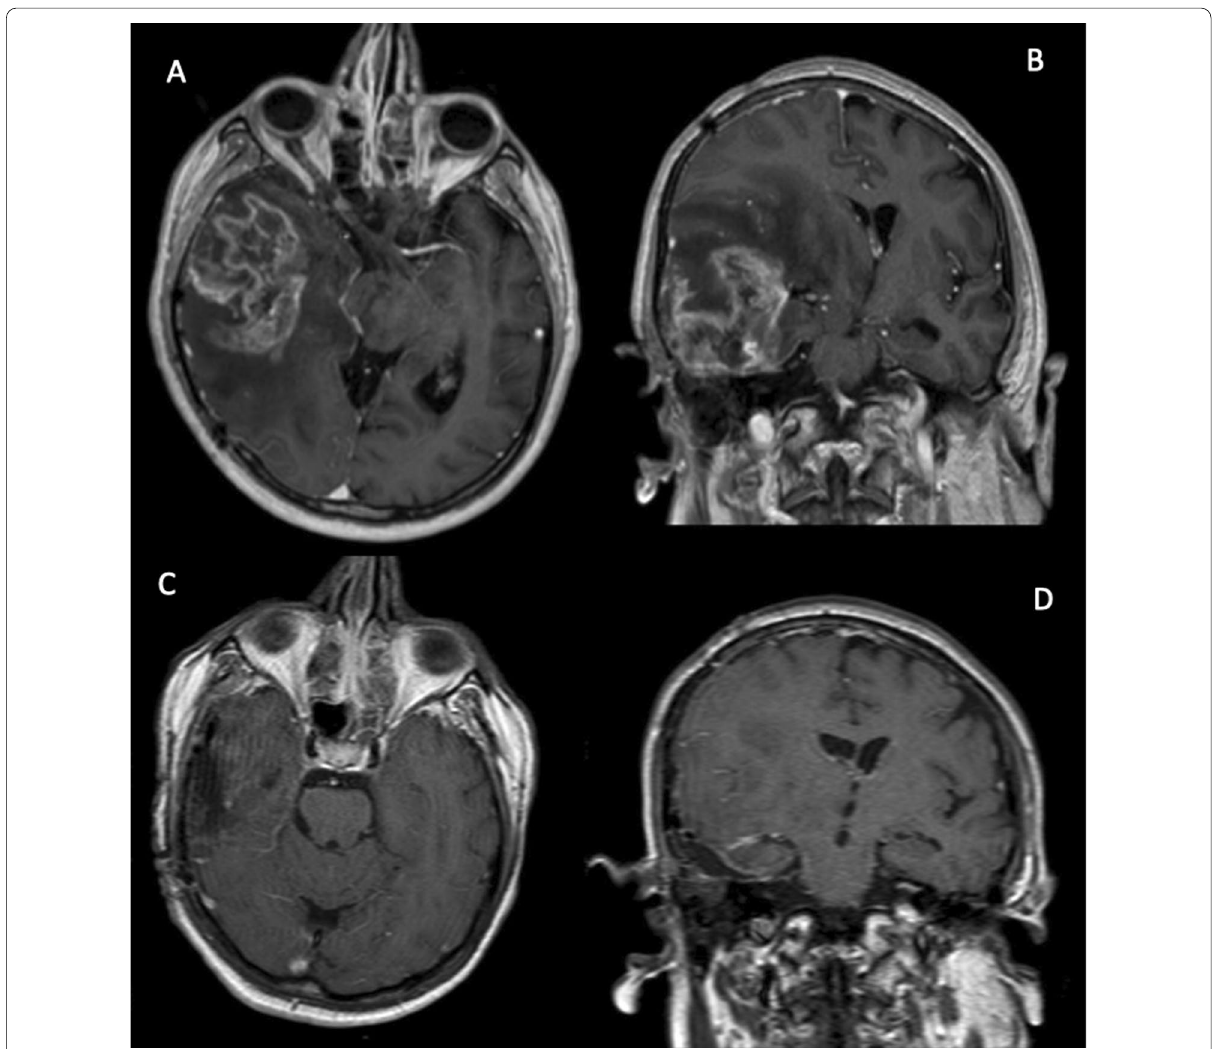
Fig. 3 Recurrence of the glioblastoma. A , B Preoperative axial and coronal cranial MRI scan. C , D Postoperative axial and coronal cranial MRI